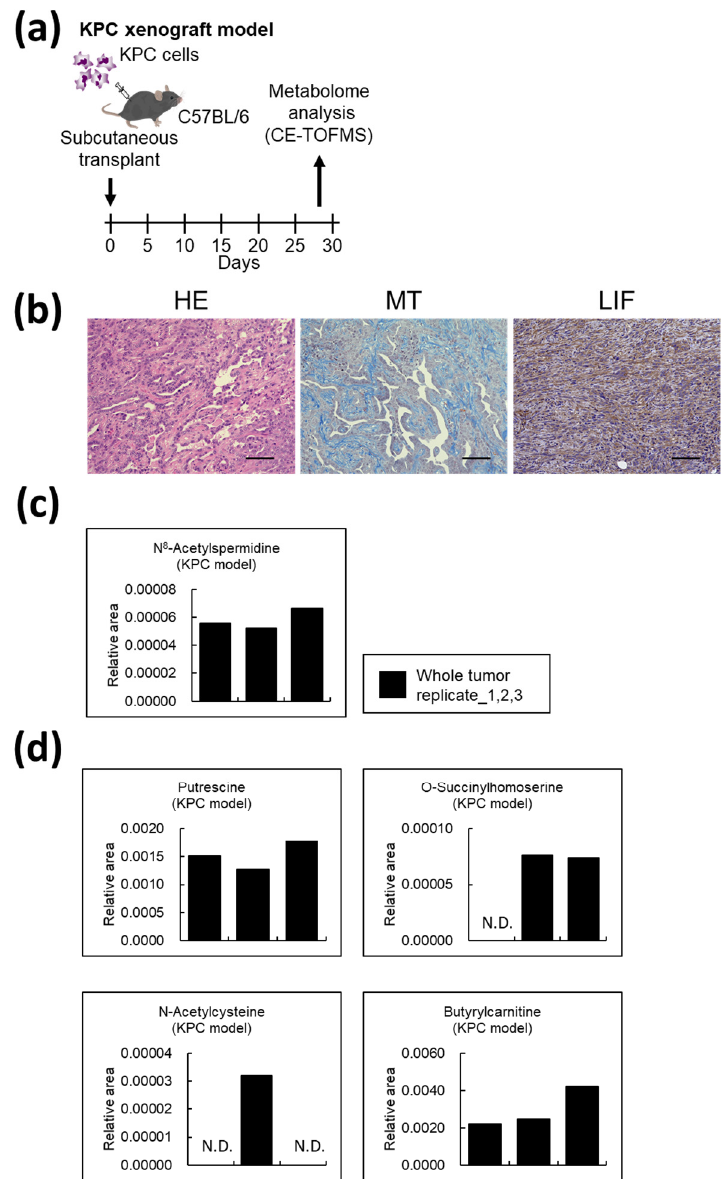
Figure 7. Unique metabolites detected in adipose-derived cancer-associated fibroblasts (AD-CAFs) in vitro were also detectable in mouse pancreatic cancer models: ( a ) Schematic illustration of the KPC xenograft model and treatment protocol. KPC cells were transplanted subcutaneously into C57BL/6 mice, and excised tumors were subjected to metabolomic analysis; ( b ) Representative images of the KPC xenograft tumor. These tumors recapitulate the human pancreatic cancer. Scale bar: 100 µ m; ( c ) N8-acetylspermidine was detected in the KPC xenograft tumor; ( d ) Four metabolites detected solely in the AD-CAFs and not in the progenitors were also detected in the KPC xenograft